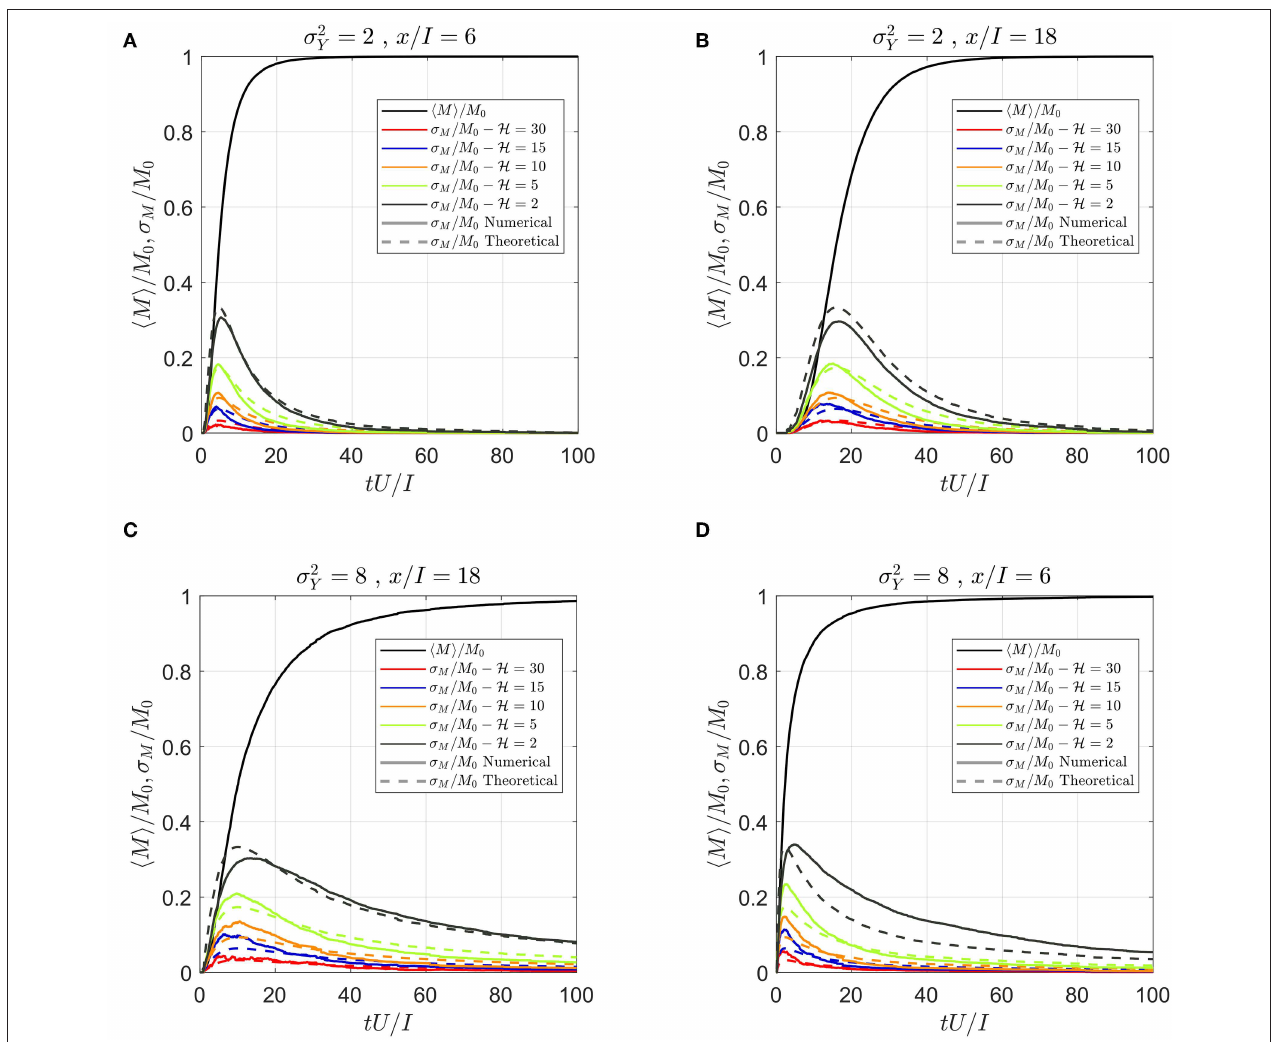
FIGURE 4 | Comparison of solution (11) with the numerical simulations of Jankovic et al. (2017), which were carried out for single realizations and a large source H = L y / I = L z / I = 90. The comparison is achieved by dividing the initial plume in subdomains of H = 2,5,10,15,30 regarded as independent realizations, a proxy for Monte Carlo simulations. The BTC M and its standard deviation (SD) for the multivariate normal field at two Control Plane distances (6 I and 18 I ) and two degrees of heterogeneity ( σ 2 Y = 2 and σ 2 Y = 8) are represented. The SD predictions by the simplified model (11) are represented by the dashed